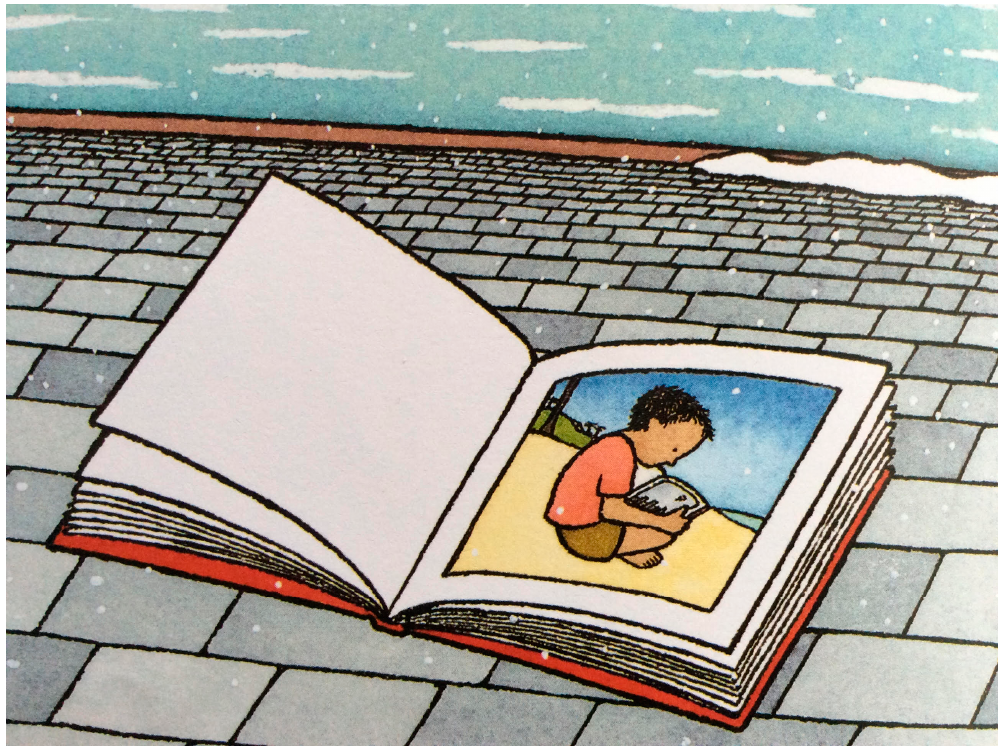
Figure 2. Detail from The Red Book